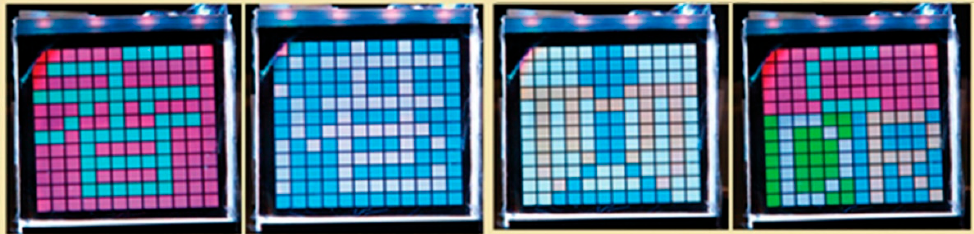
Figure 5. Prototyp е s о f th е field sequential color displ ау (12 × 12 pixels), based on the RSPES Н